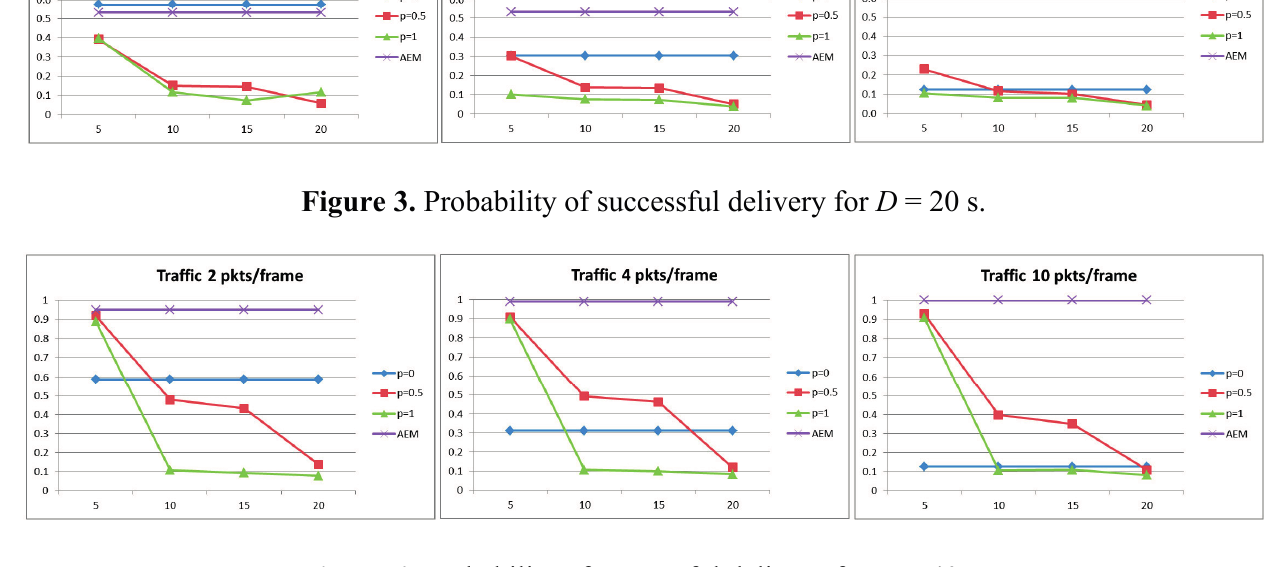
Figure 4. Probability of successful delivery for D = 40